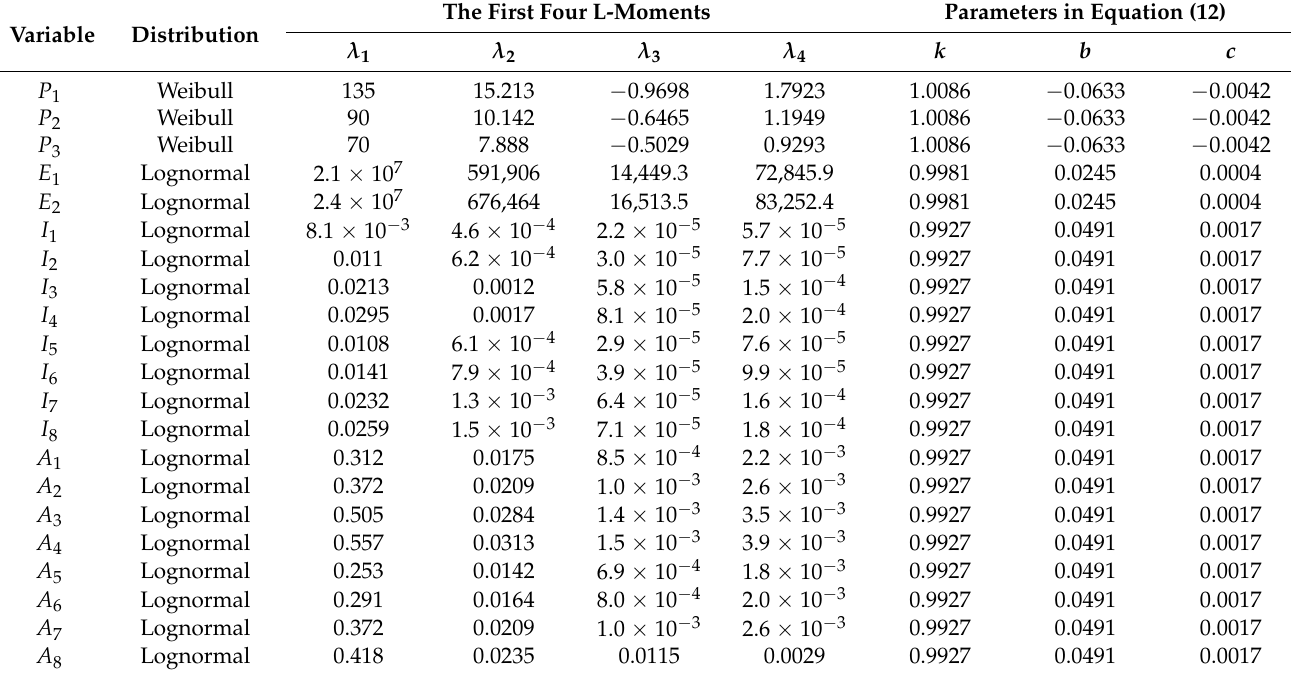
Table 4. Probabilistic information of the basic random variables for Example